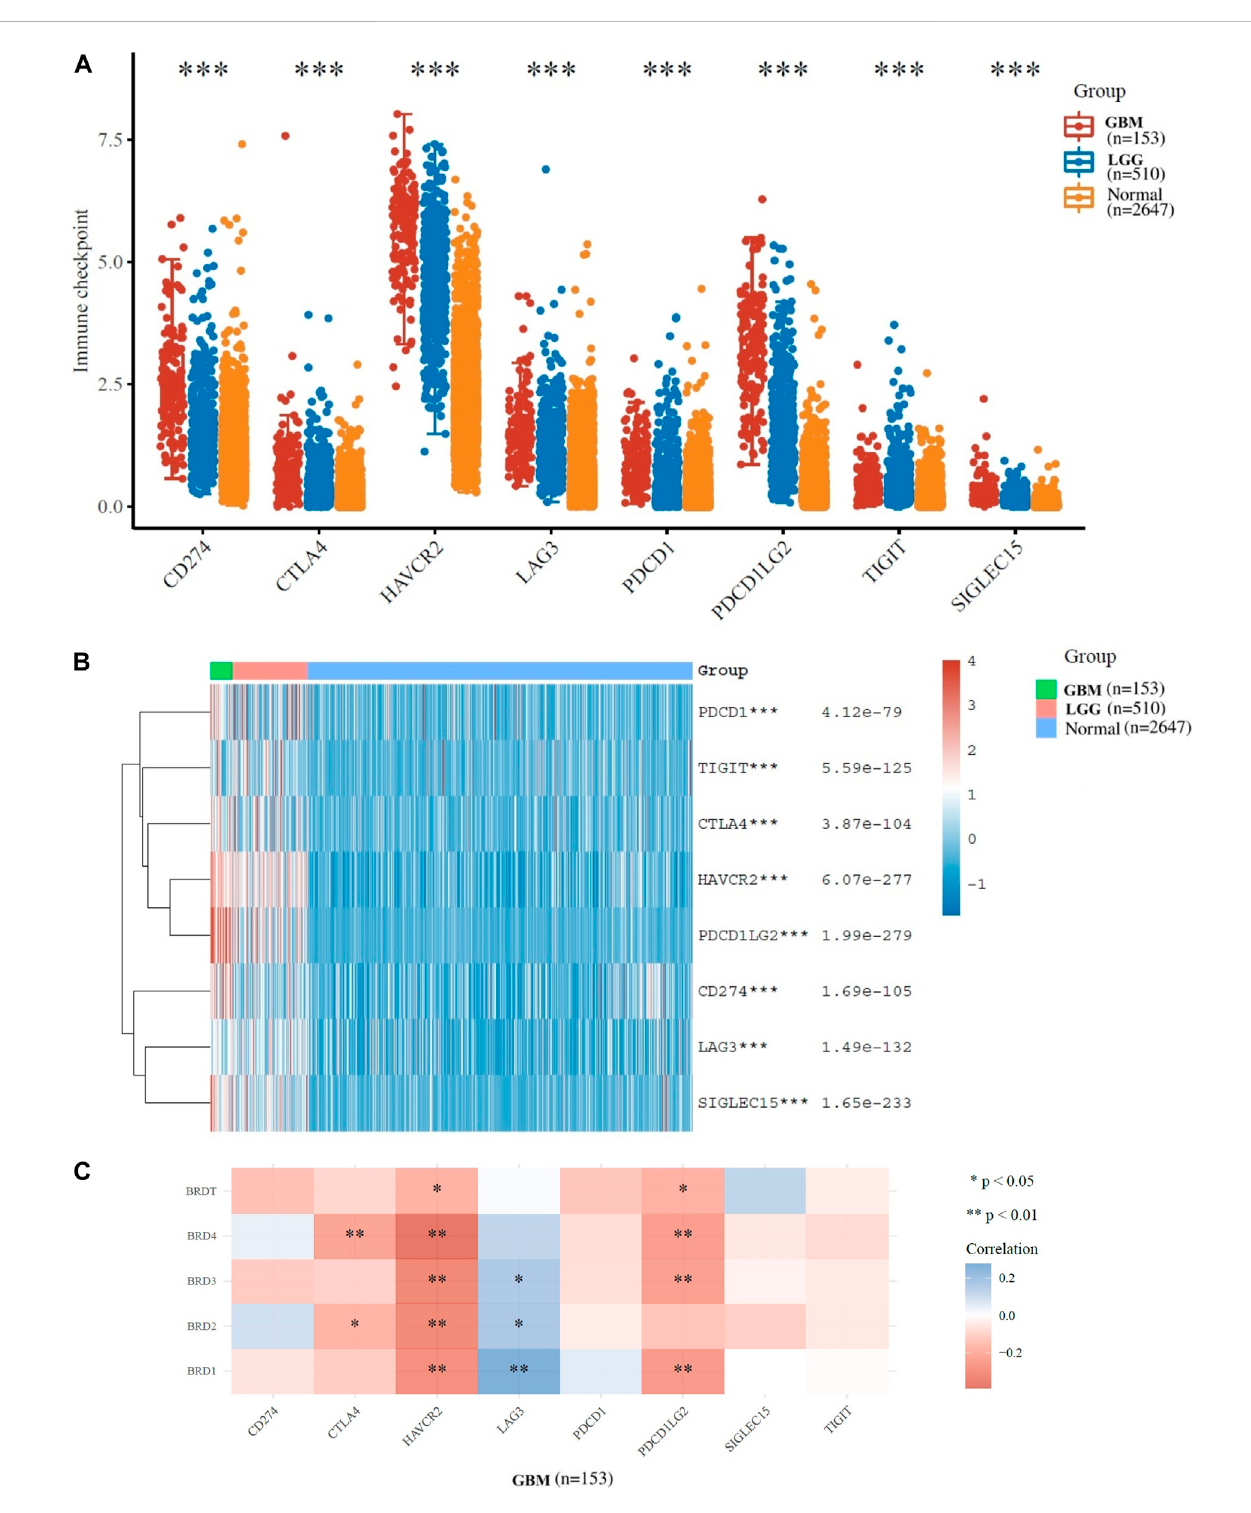
FIGURE 4 ImmunologicalcheckpointrelatedtranscriptionallevelandexpressioninGliomasamplesinTCGAdataset. (A) Theexpressiondistributionofimmunecheckpoints gene(CD274,CTLA4,HAVCR2,LAG3,SIGLEC15, TIGIT,PDCD1andPDCD1LG2)intumor andnormaltissues. (B) Theheatmapofgeneexpressionrelatedto immune checkpoint (* p < 0.05, ** p < 0.01, *** p < 0.001). (C) The correlation between BET genes expression and immune checkpoint gene expression in